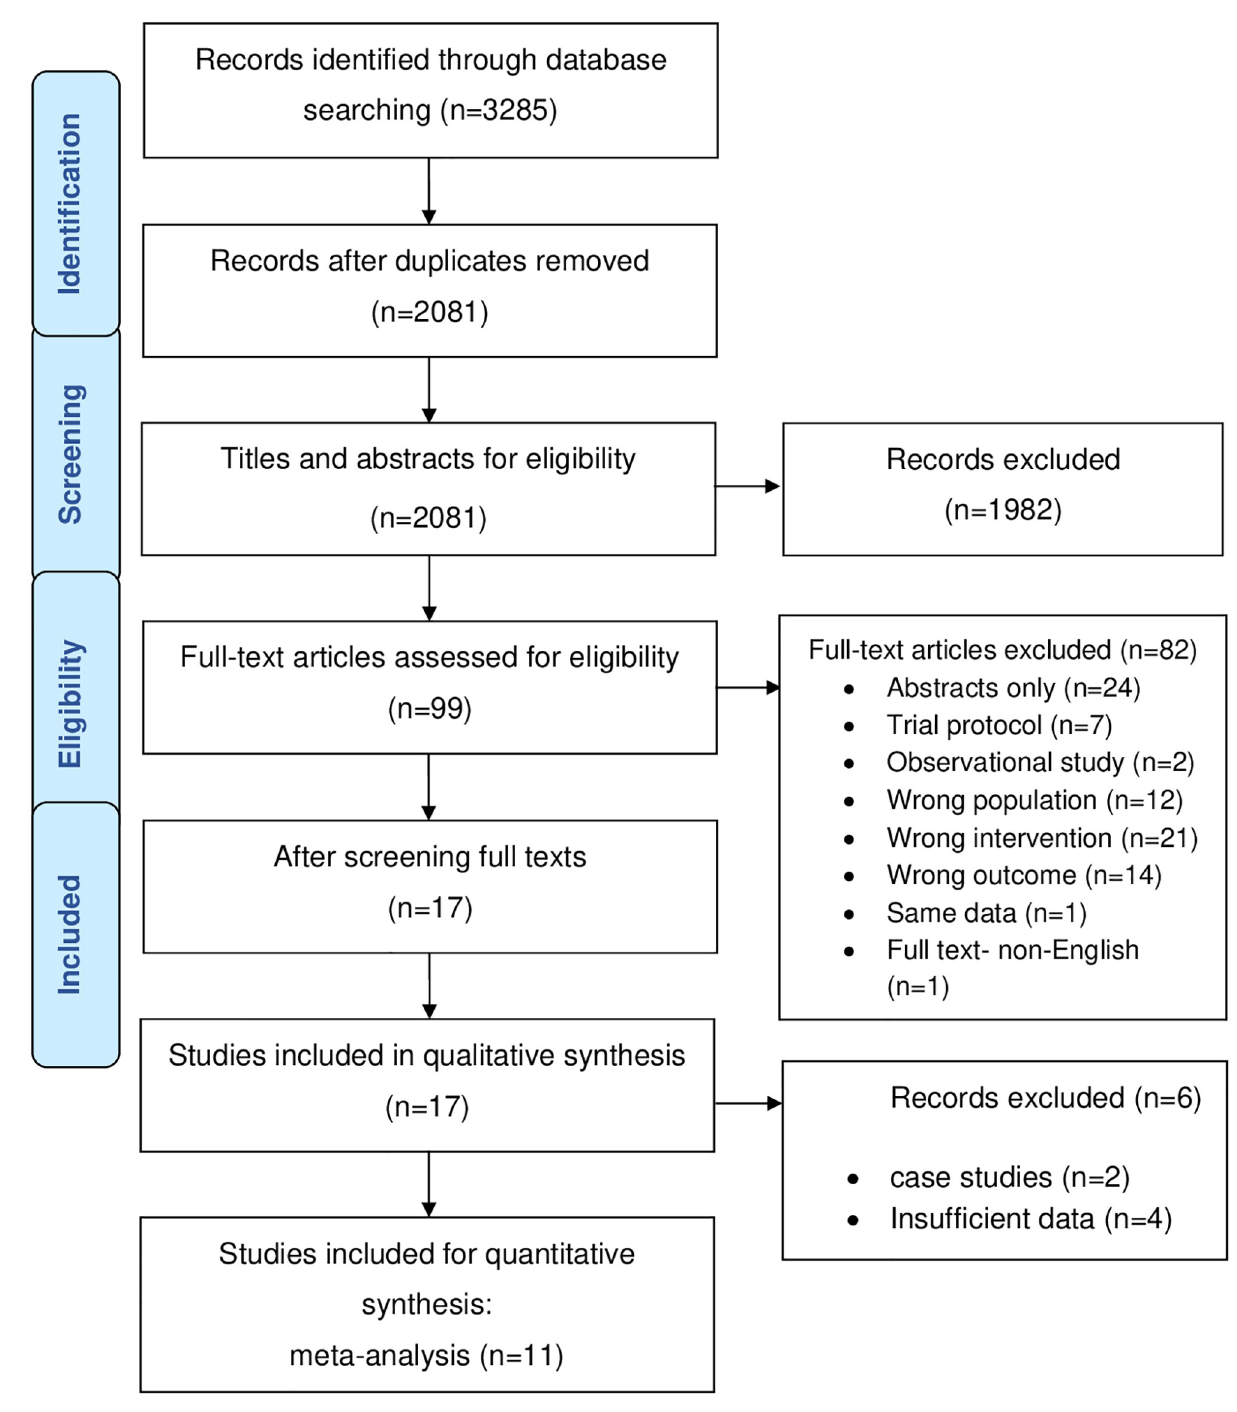
Fig 1. PRISMA flow diagram of study selection.